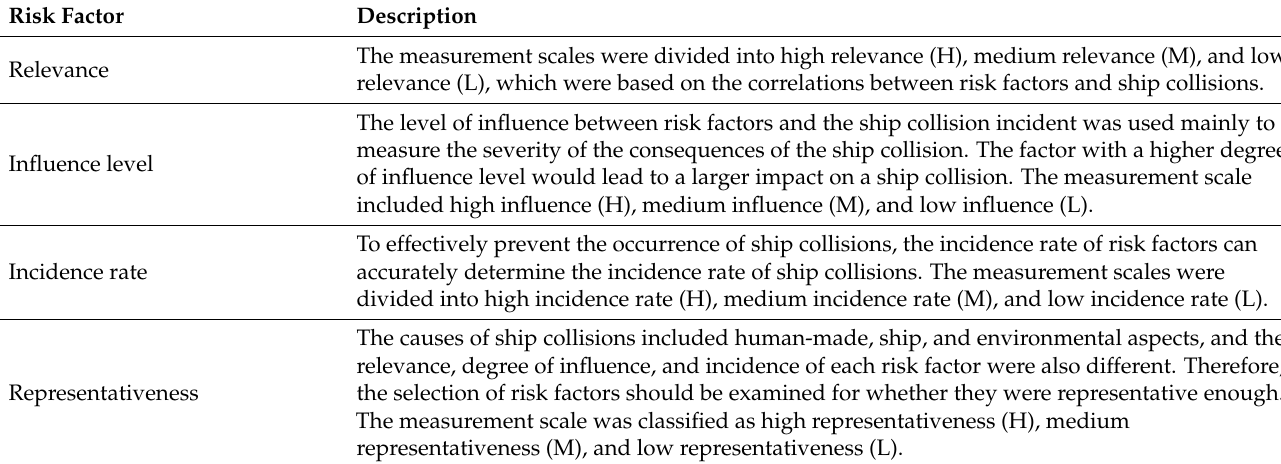
Table 3. Description of the risk factor selection criteria.